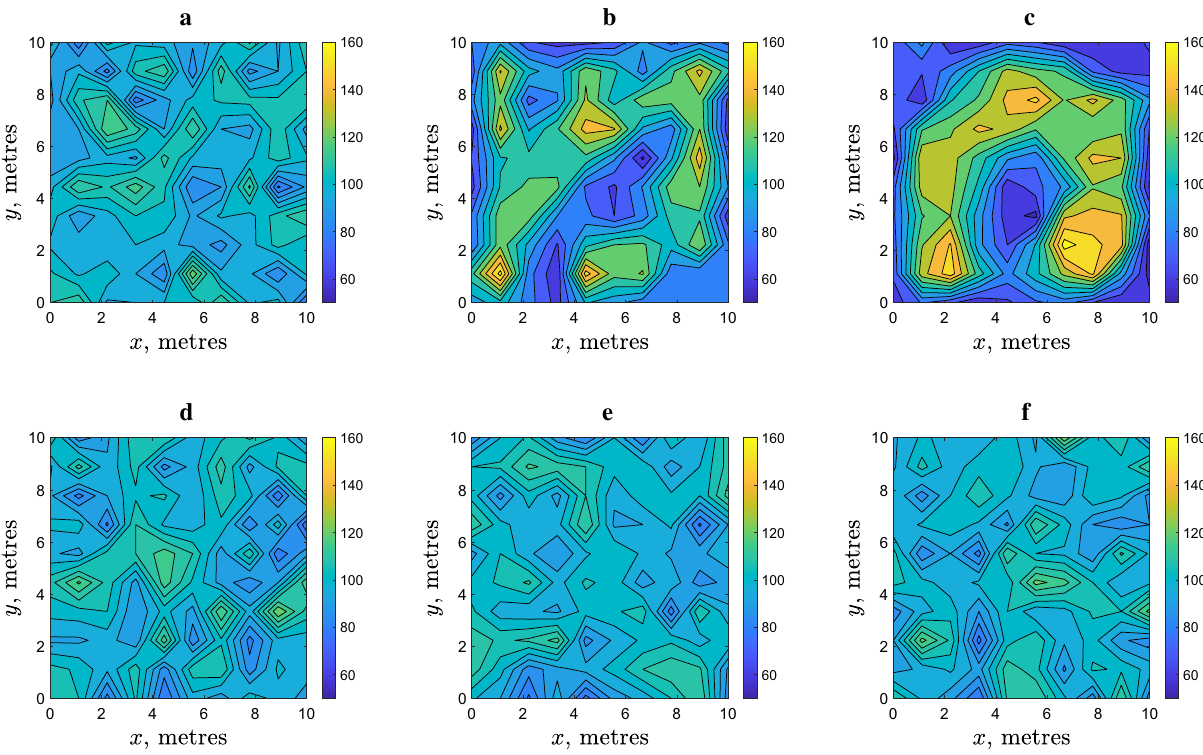
10 4 slugs shown at different moments of time: ( a , d ) t Figure 3. The spatial distribution of N = t 10 3 , ( c , f ) t 10 4 . Distributions in the upper row ( a – c ) are obtained using the density dependent movement = = model (as is described in “Methods” section). Parameter values are the same as in Fig. 2. For comparison, the lower row ( d – f ) shows the distributions obtained in the case of density independent movement. While patches of high density (shown by yellow colour) emerge in the course of time in the case of density dependent movement, they do not emerge in the case of purely random, density independent